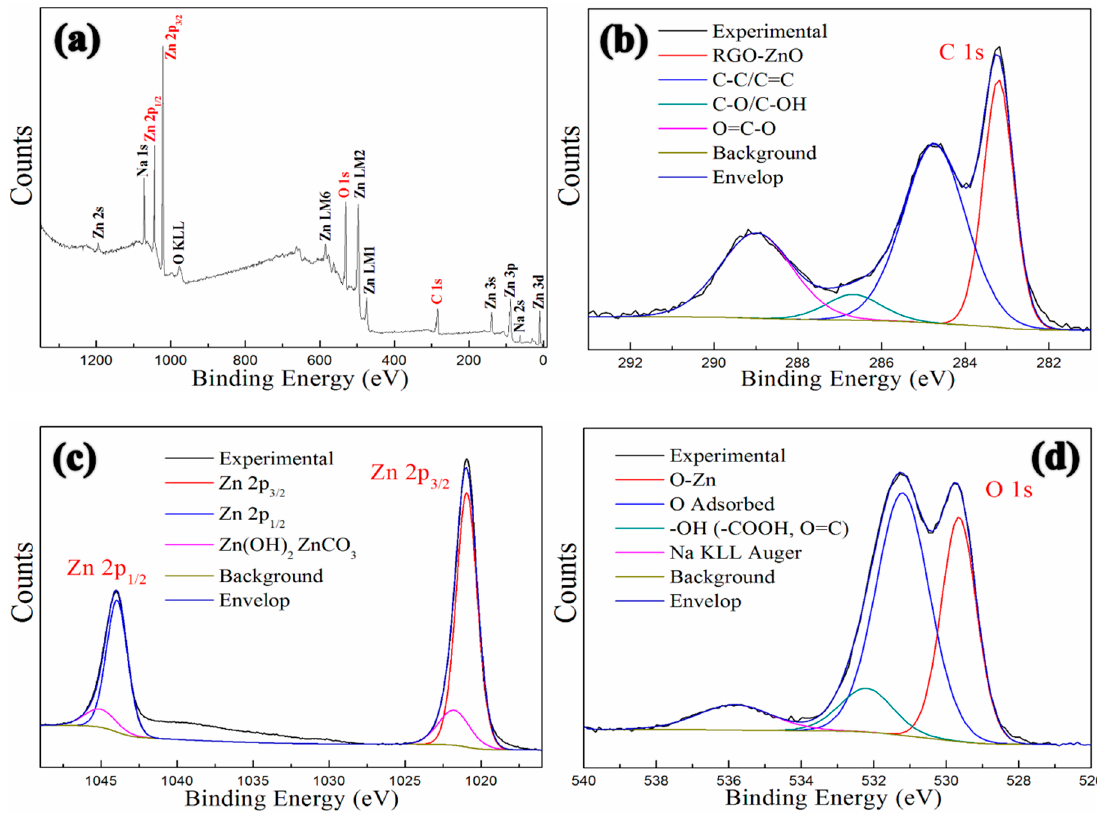
Figure 7. XPS spectra of GNP-ZnO hybrids: full spectrum ( a ), C 1s ( b ), Zn 2p ( c ), O 1s ( d ).